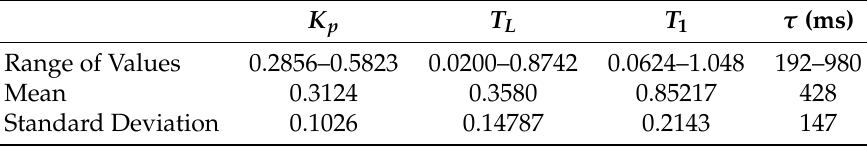
Table 4. Range of values of parameters for lead-lag pilot model